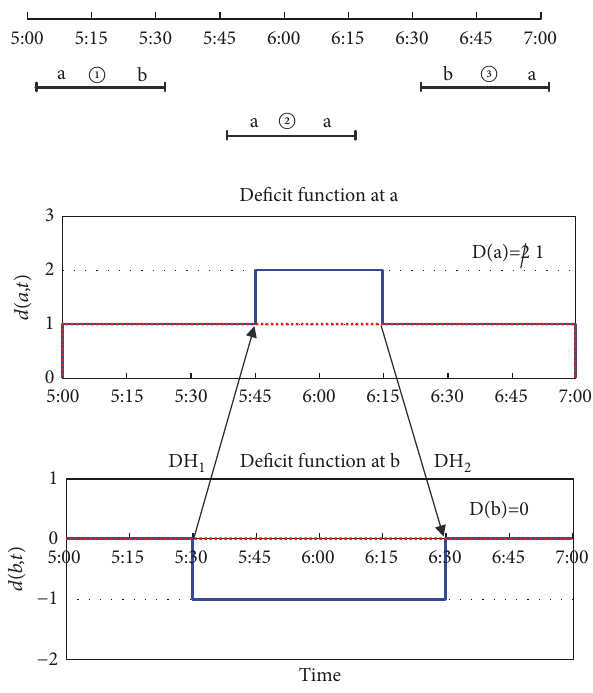
Figure 3: An example of the DH trips.